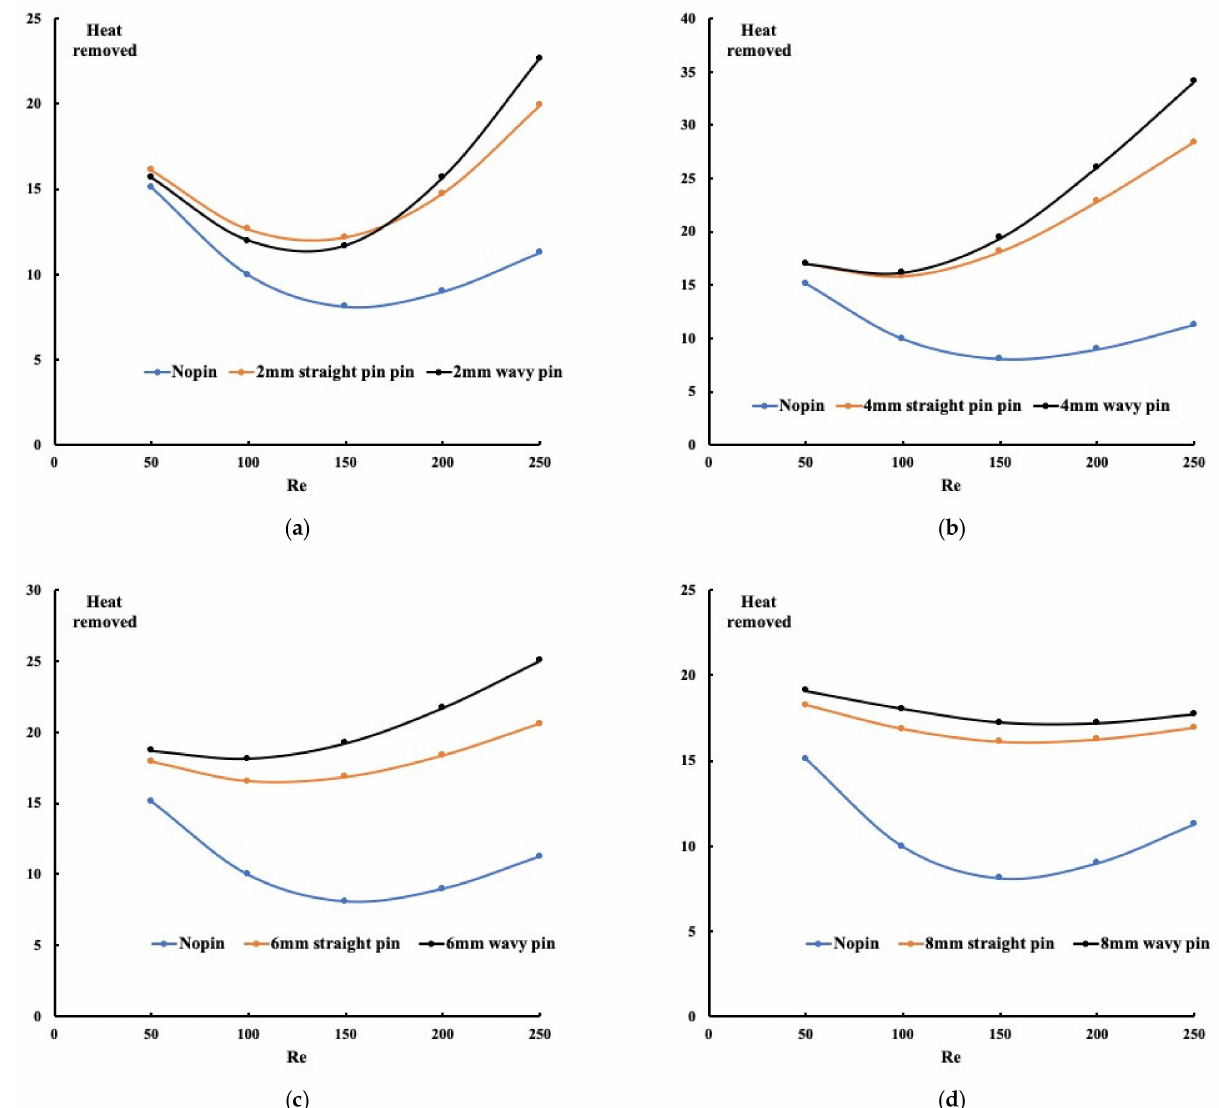
Figure 7. Heat removed for all configurations (( a ) 2 mm pin height, ( b ) 4 mm pin height, ( c ) 6 mm pin height, ( d ) 8 mm pin